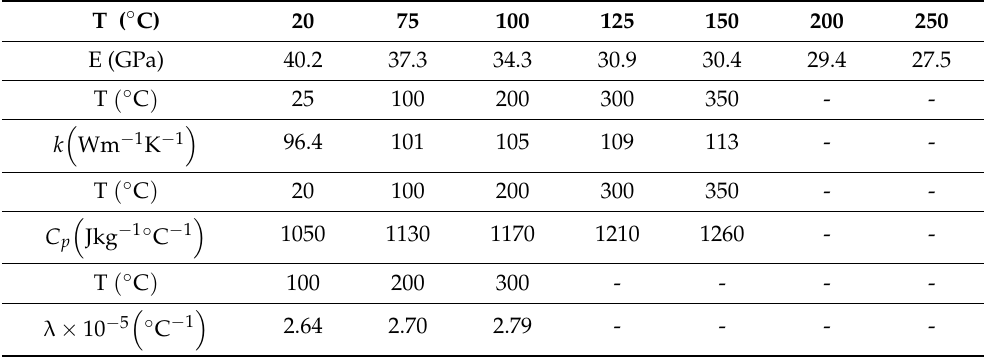
Table 7. The thermo–mechanical properties of AZ31B